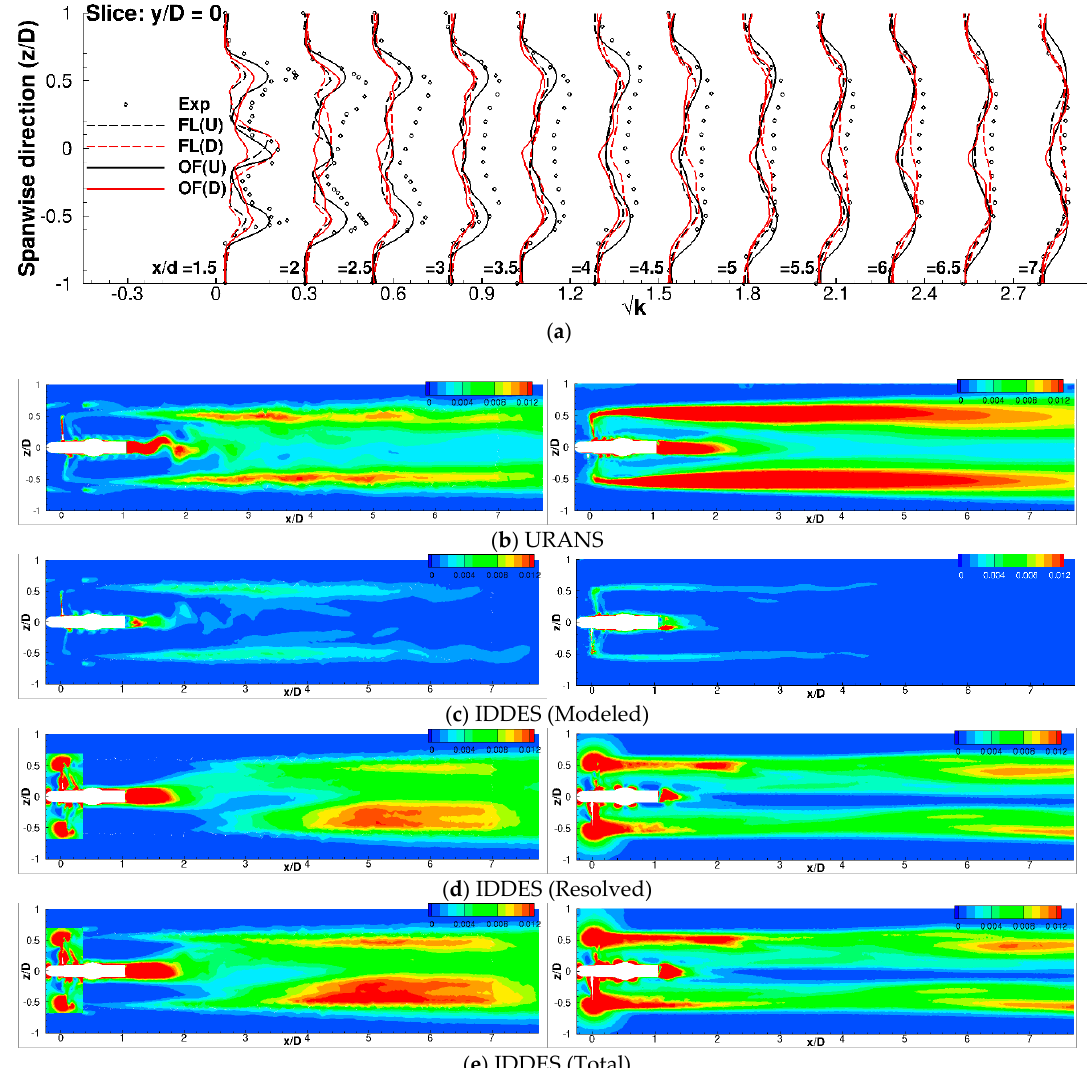
√ Figure 12. ( a ) √𝑘 profiles at different streamwise locations are compared with experimental data [2]. k profiles at di ff erent streamwise locations are compared with experimental data [2]. Figure 12. ( a ) Contours of turbulent kinetic energy (TKE) predicted by Ansys/Fluent (left panels) and OpenFOAM Contours of turbulent kinetic energy (TKE) predicted by Ansys / Fluent (left panels) and OpenFOAM (right panel) simulations at y/D = 0 plane. ( b ) TKE predicted by URANS. ( c ) Modeled component, ( d ) (right panel) simulations at y / D = 0 plane. ( b ) TKE predicted by URANS. ( c ) Modeled component, resolved component and ( e ) total TKE predicted by IDDES. ( d ) resolved component and ( e ) total TKE predicted by